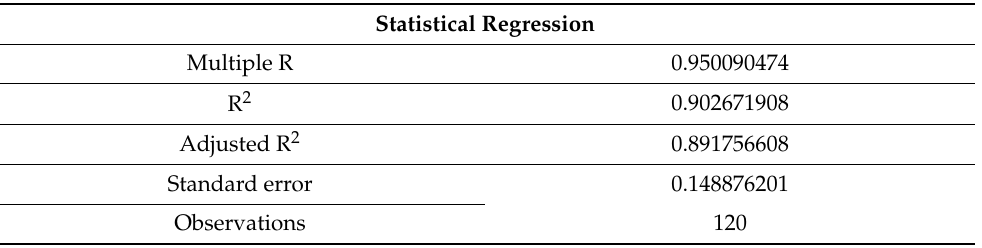
Table 9. Results of linear regression between frailty criteria at recovery and after 2 years, and type of surgery, with estimated